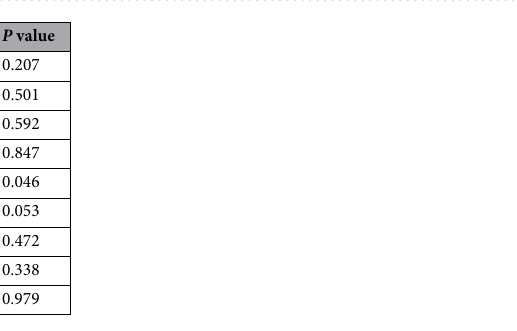
Table 2. Univariate cox regression models exploring associations between monocyte subset percentages with time to end of post-intervention primary patency outcome. n = 20 pre fistuloplasty patients, n = 20 post fistuloplasty